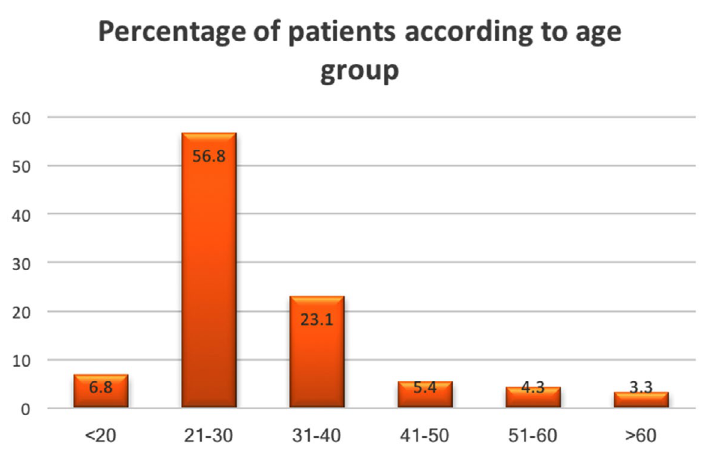
Fig. 1. Distribution of the Percentage of patients according to age group.